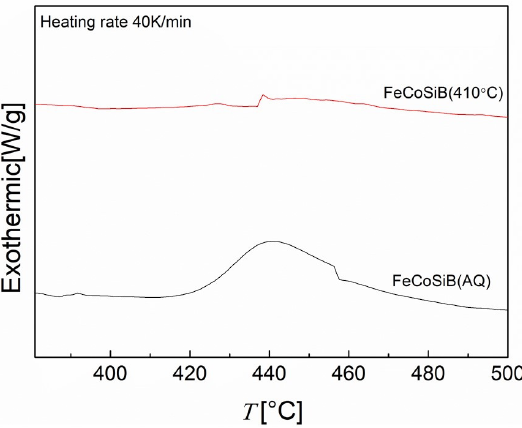
Figure 5. X-ray diffraction (XRD) patterns of Metglas ribbons on ( a ) shiny sides and ( b ) dull sides. Thermal stability was examined via differential scanning calorimetry (DSC) for AQ- FeCoSiB and the annealed FeCoSiB at a heating rate of 40 K/min, as shown in Figure 6.